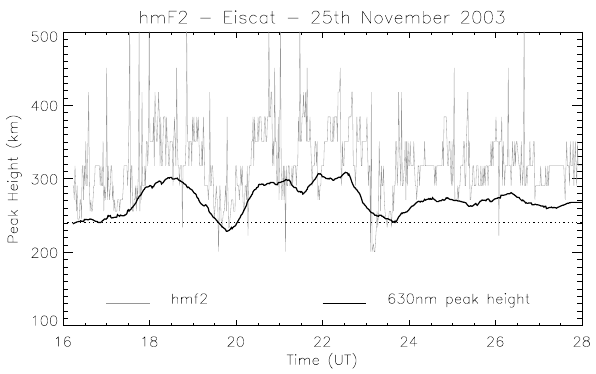
Fig. 15. EISCAT hmF2 values for the 25 November 2003 (grey) and estimated OI emission altitude (black). The presumed altitude of 240km is shown with a horizontal dotted line.